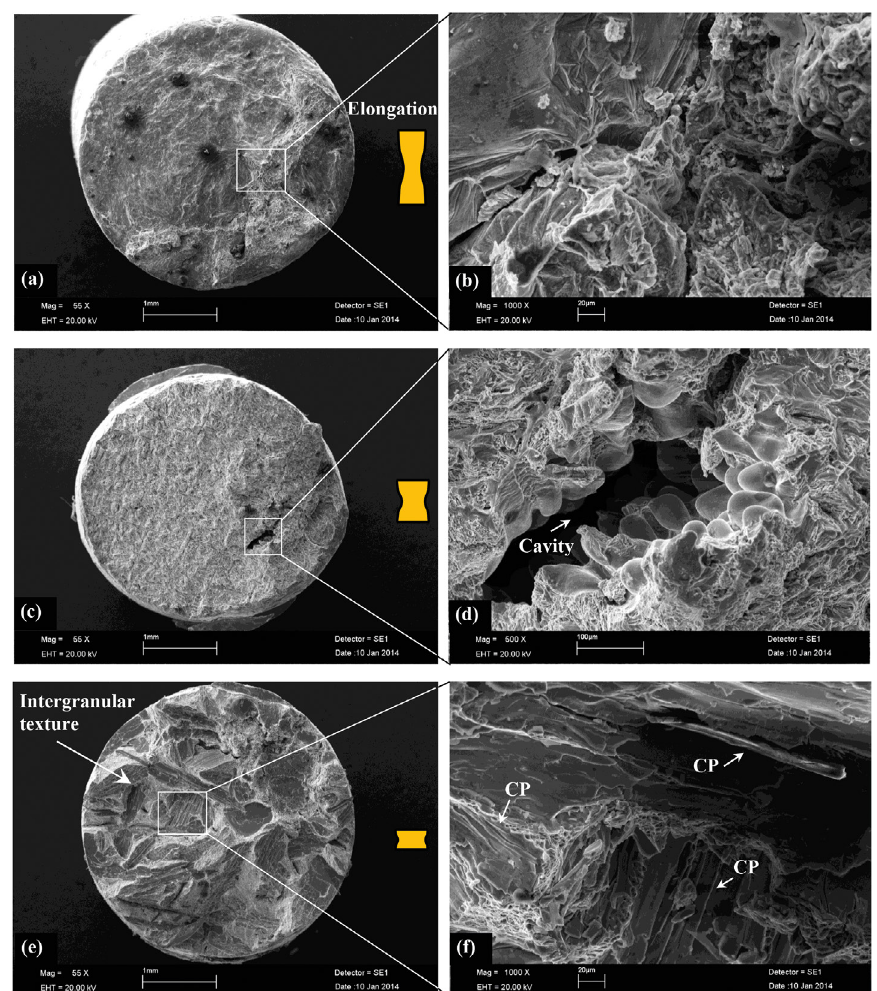
Fig. 12 SEM fractographs showing tensile fracture surface of Al–1.9Mn–xFe alloys for biggest growth velocity ( V =978 μm/s) (a, b) Al–1.9Mn–0.5Fe (c, d) Al–1.9Mn–1.5Fe (e, f) Al–1.9Mn–5Fe